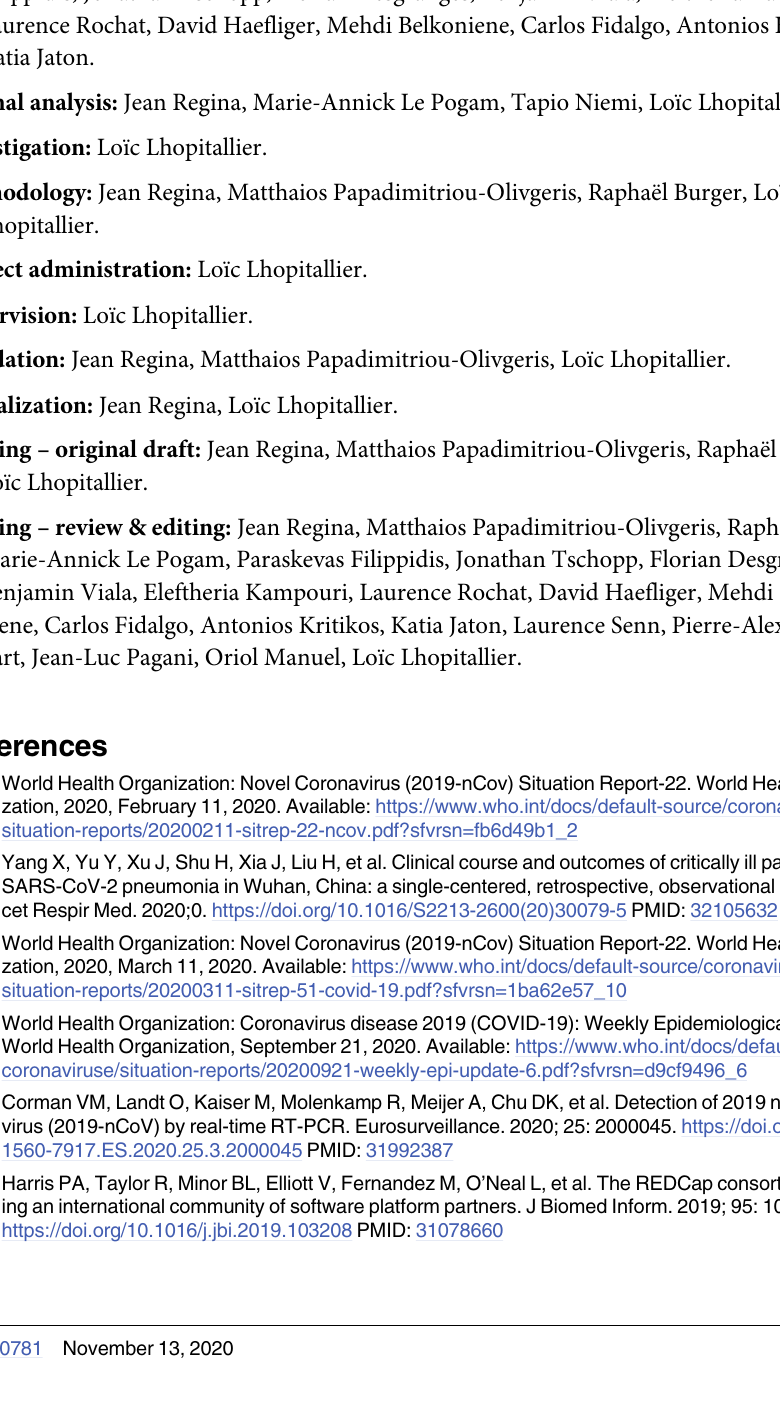
S1 Table. Unadjusted risk factors associated with mechanical ventilation at 14